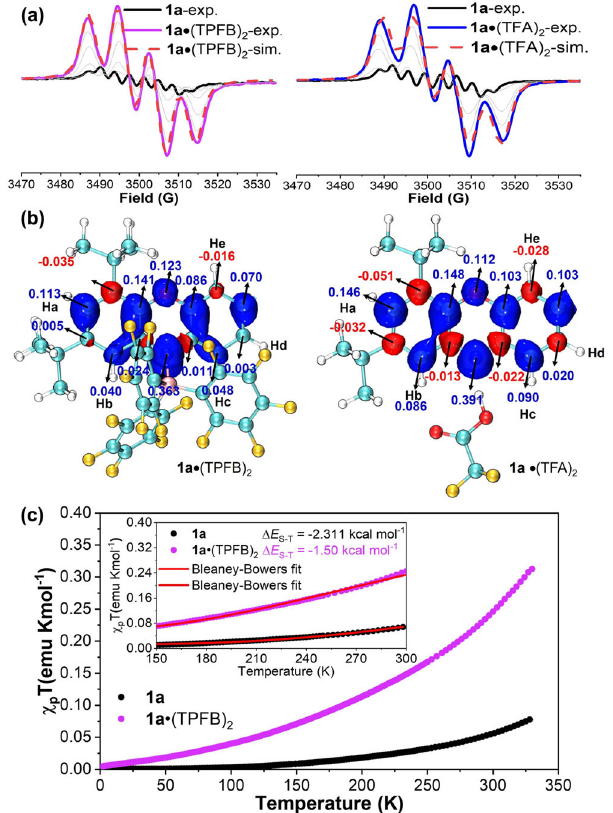
Fig. 8 Magnetic property changes of 1a in the reversible Lewis acid-base reaction. a EPR spectral changes during the titration of 1a with TPFB (left) and TFA (right), and EPR simulation of 1a (cid:129) (TPFB) 2 and 1a (cid:129) (TFA) 2 . b Calculated spin density distributions of 1a (cid:129) (TPFB) 2 (left) and 1a (cid:129) (TFA) 2 (right). For clarity, only one-half of molecule is shown. c Comparison of χ T – T plot for 1a and 1a (cid:129) (TPFB) fi tting plots (red 2 . The inset shows the best solid line) and singlet-triplet energy gap obtained with the Bleaney-Bowers equation. χ p = χ mol - χ d , χ d : diamagnetic susceptibility ( χ d of 1a : ~ − 425 × 10 − 6 emu mol -1 , χ (cid:129) (TPFB) − 846 × 10 -6 emu mol -1 d of 1a 2 : ~